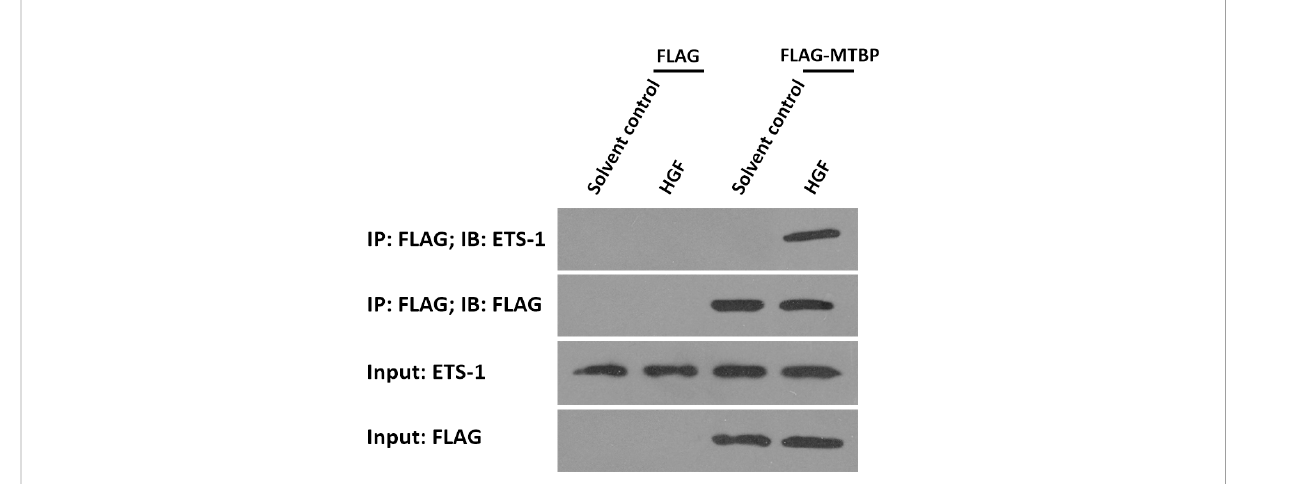
FIGURE 5 MTBP interacts with ETS-1 in MHCC97-H cells. MHCC97-H cells were cultured and transfected with FLAG vectors or FLAG-MTBP vectors. Then, MHCC97-H cells were harvested for co-immunoprecipitation assays in the absence or presence of HGF. The interaction between MTBP or ETS- 1 was shown as “ IP: FLAG; IB: ETS-1 ”